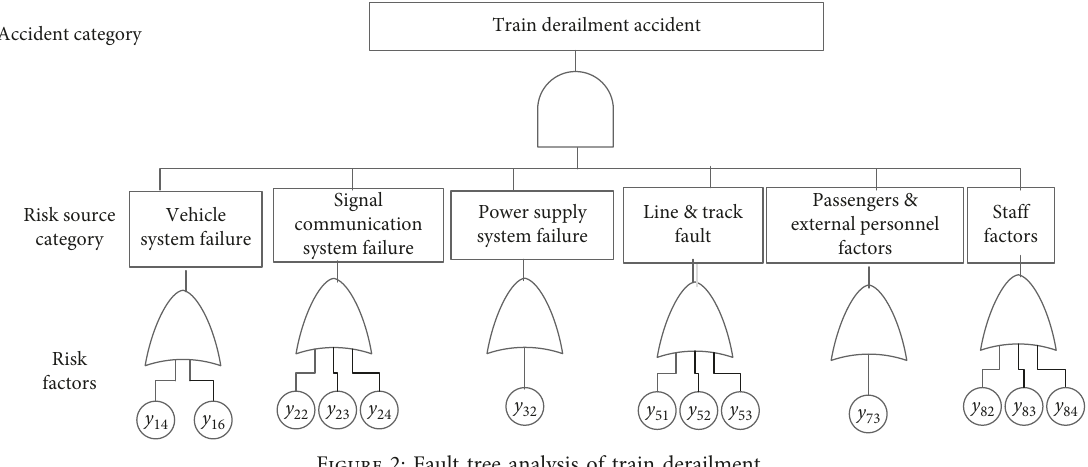
Figure 2: Fault tree analysis of train derailment.